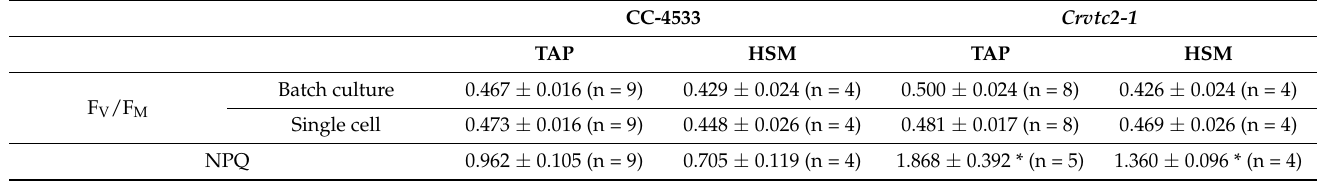
Table 1. F V /F M and NPQ values of CC-4533 and Crvtc2-1 cultures grown in HSM or TAP media. F V /F M measurements were carried out on a batch culture, using a Handy-PEA fluorometer or on single cells in the “Tulip” microfluidic platform. NPQ values were obtained in the “Tulip“ microfluidic platform, after 30 min of light adaptation to 383 µ mol photons m − 2 s − 1 (TAP) or 151 µ mol photon m − 2 s − 1